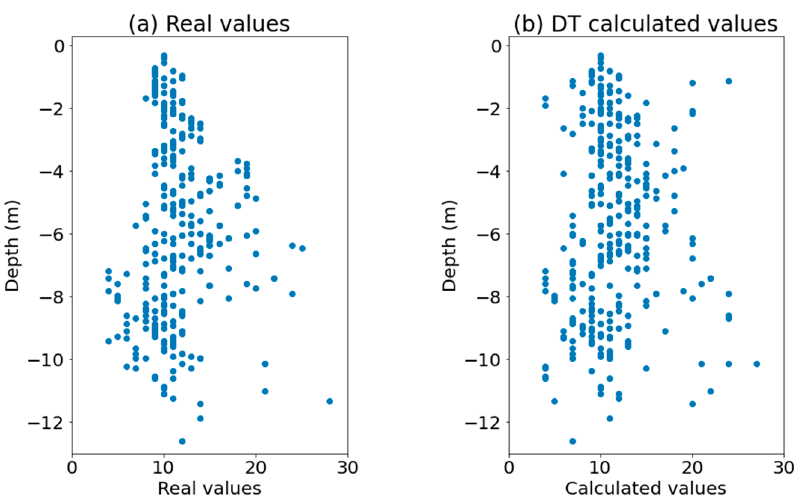
Figure 12. Real and calculated values for site 2. ( a ) Real values. ( b ) Values calculated by DT. ( c ) Values calculated using RF.